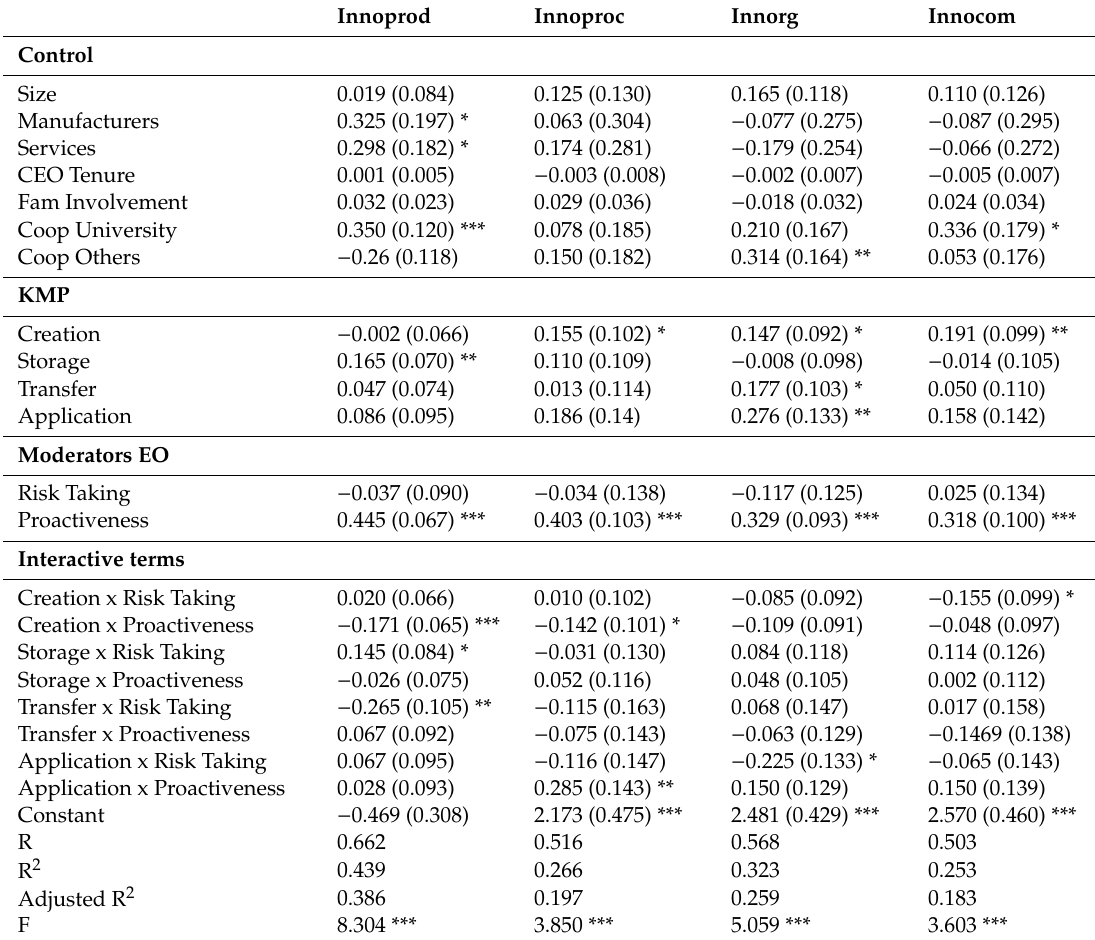
Table 2. Ordinary least squares regression results. EO: entrepreneurial orientation, KMP: knowledge management